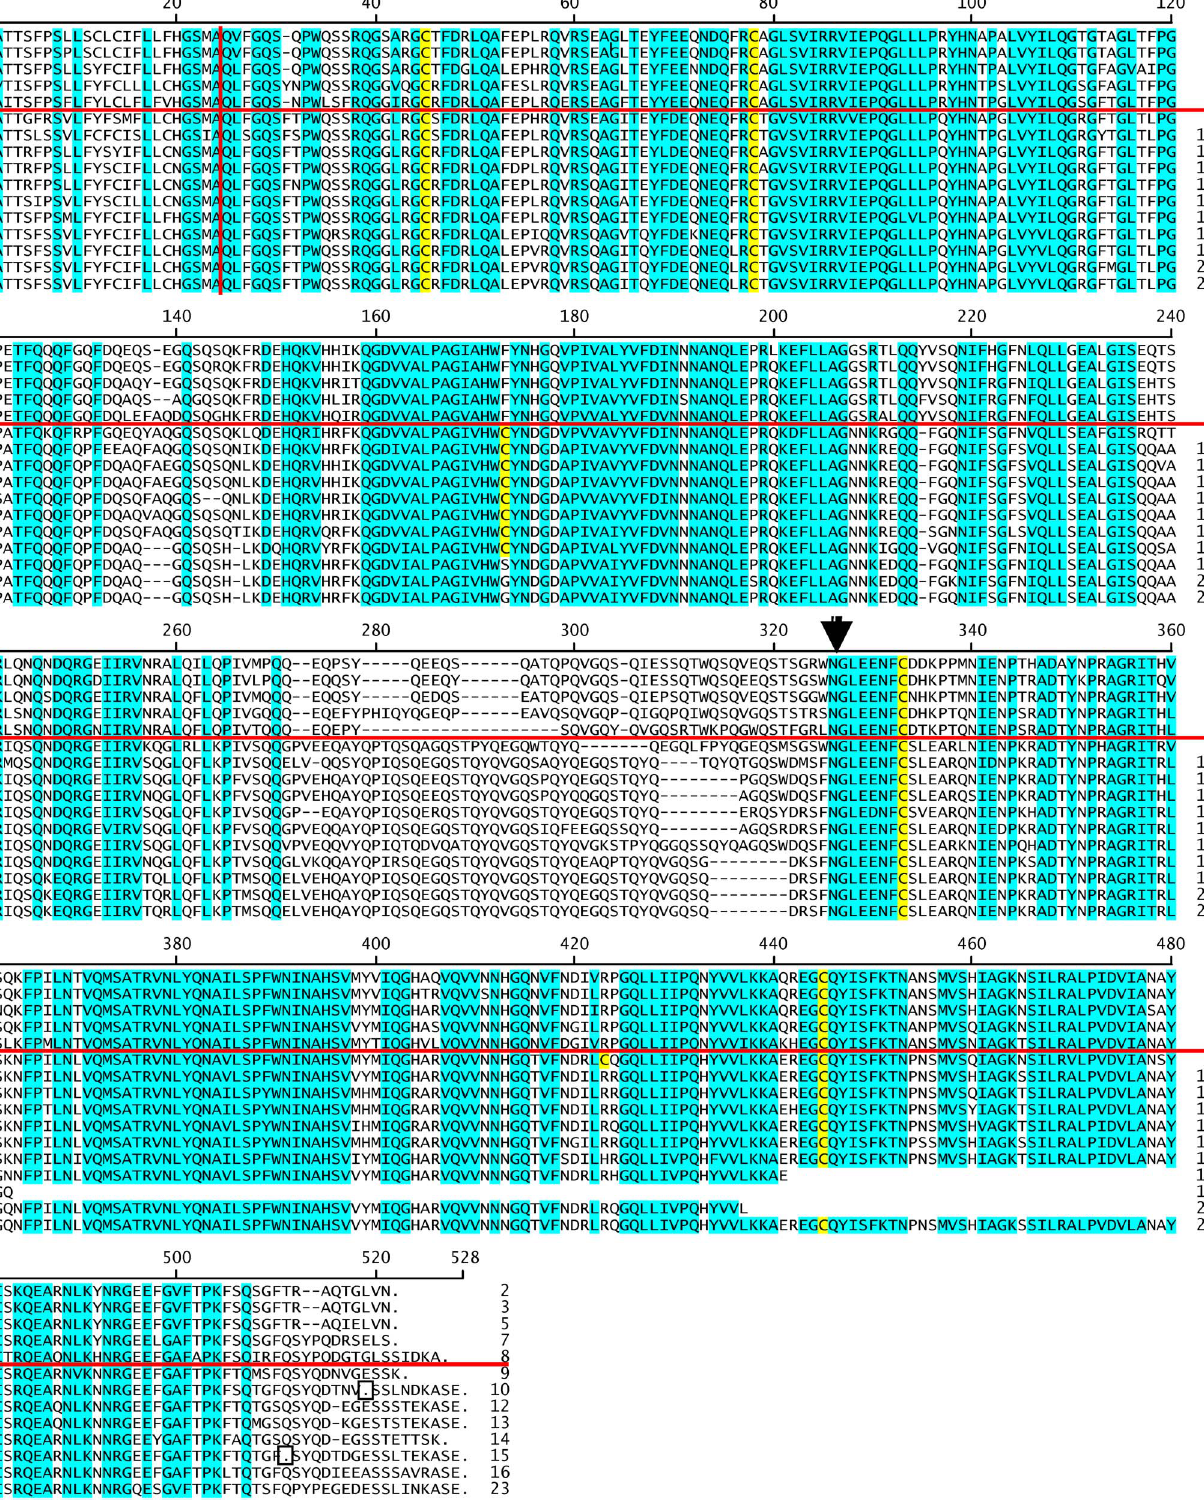
Figure 6. Alignment of oat globulin amino acid sequences. Sixteen of the CDC Dancer globulin derived amino acid sequences are aligned by ClustalW. Sequences are labeled by number only; i.e., ‘‘2’’ indicates sequence Glo-2. Not shown are eight sequences that are either C-terminal truncated or almost identical to shown sequences. The horizontal red line separates two main classes of oat globulins. The vertical red line indicates the end of the signal peptide. Amino acid residue positions conserved in all sixteen sequences are shaded blue. Conservation is defined as the same amino acid or amino acids with similar characteristics; i.e., D/E, F/Y, K/R, L/I/V/A, S/T. Cysteine residues are shaded yellow. The arrowhead following position 326 indicates site of the post-translational cleavage generating two disulfide crosslinked polypeptides. Premature stop codons are indicated by boxed periods in Glo-10 and Glo-15. doi:10.1371/journal.pone.0083569.g006 PLOS ONE |